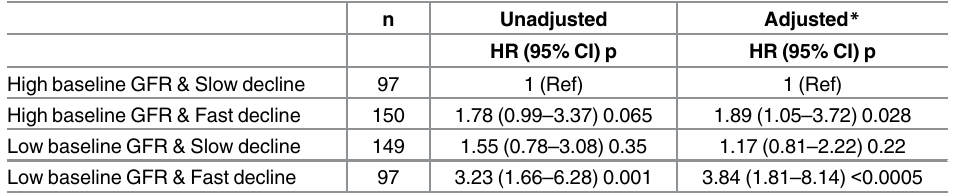
Table 4. Combined effect of baseline GFR and its rate of decline on mortality during follow-up on PD. Stratified analysis.